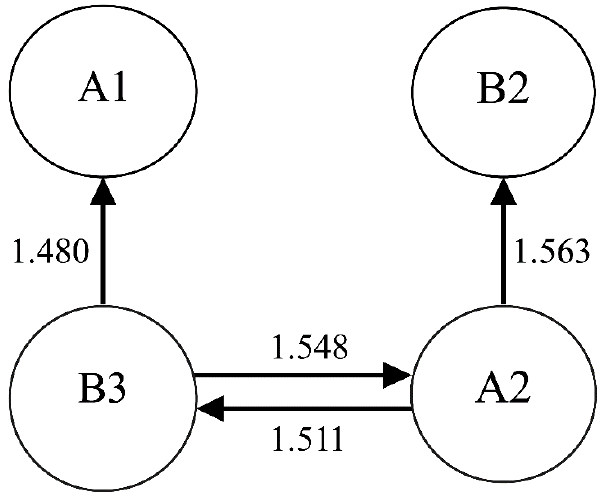
Figure 1. Cause-effect Network Relationship Map